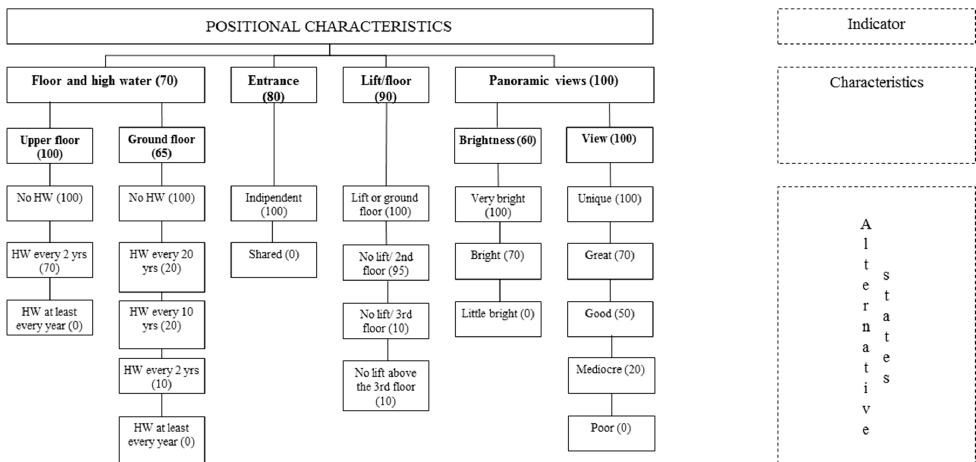
Figure 4. The structure of the “position” indicator ( c p ).